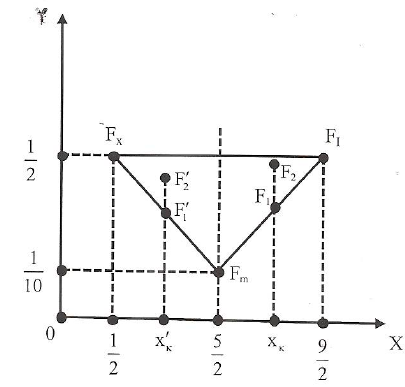
Figure 4. The triangle where the COG lies.